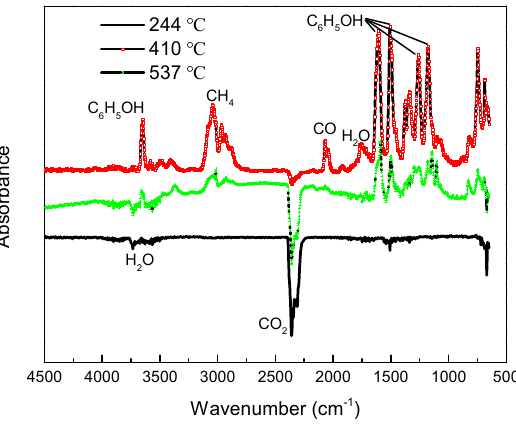
Figure 9. Spectra collected at 244, 410 and 537 °C of the degradation products of composites re- leased during TGA (20 °C/min–inert